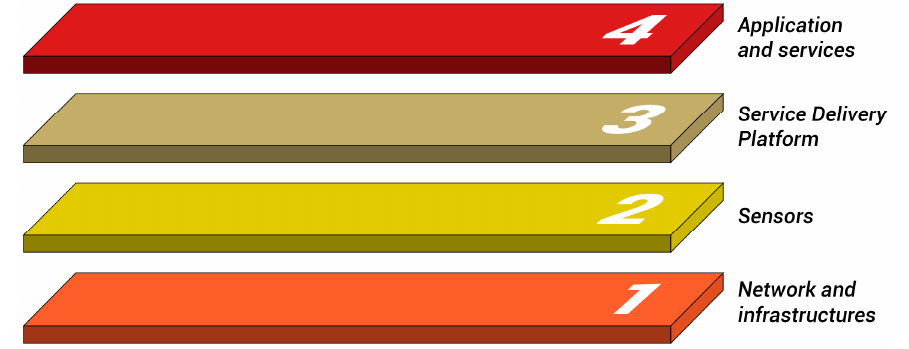
Figure 1. Horizontal dimension of a Smart Figure 1 . Horizontal dimension of a Smart city .